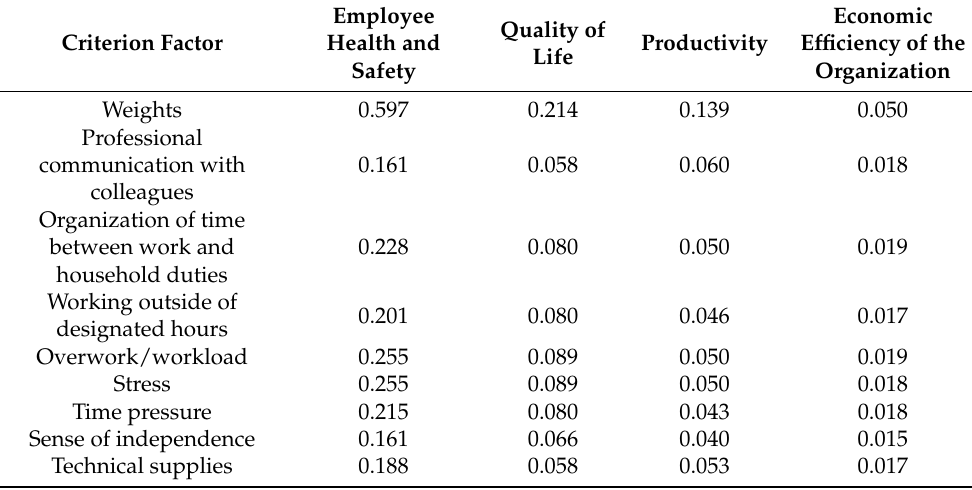
Table 7. Matrix normalized with criteria weights.